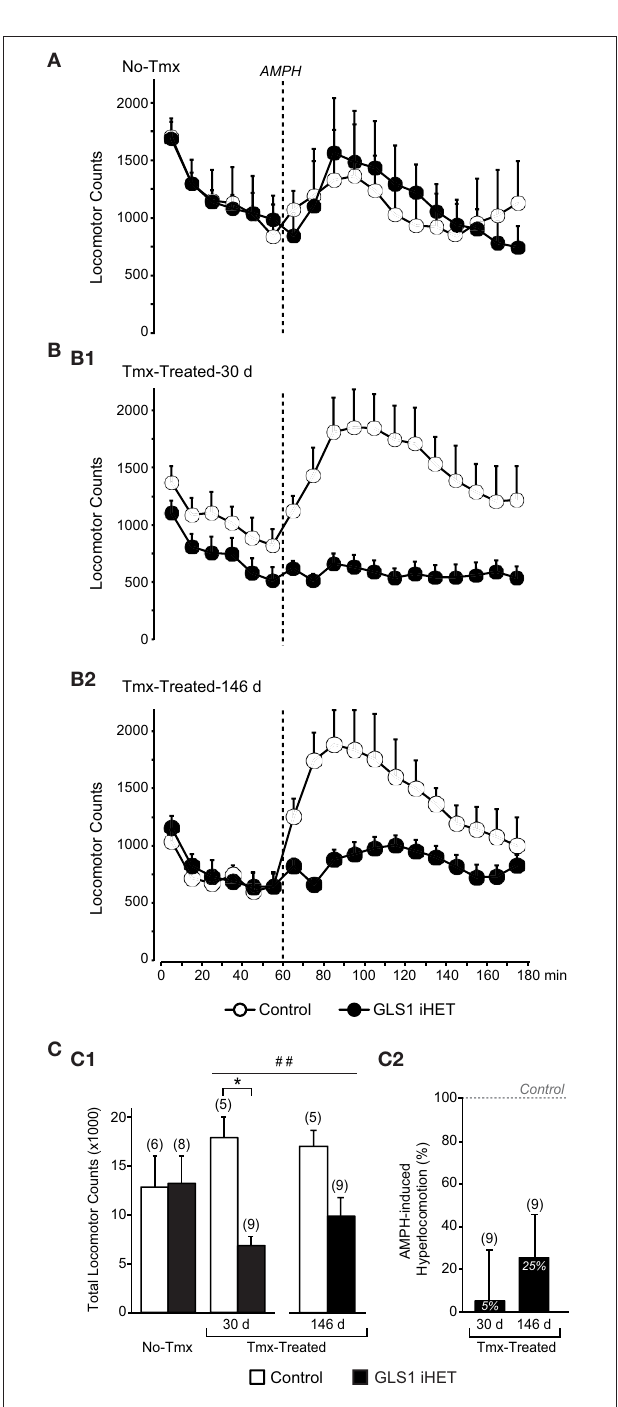
FIGURE 4 | Attenuation of amphetamine-induced hyperlocomotion in Tmx-Treated GLS1 iHet mice. (A) Amphetamine-induced locomotion. Tmx-naïve (No-Tmx) mice prior to and after amphetamine (AMPH) injection showed no genotypic difference in locomotion in the open field. (B) Locomotion before and after amphetamine for Tmx-treated mice. (B1) Tmx-Treated mice showed a marked genotypic difference in amphetamine-induced hyperlocomotion, 30 days post-Tmx. Factorial ANOVA revealed a significant genotype × time effect of amphetamine ( p < 0.05 ),